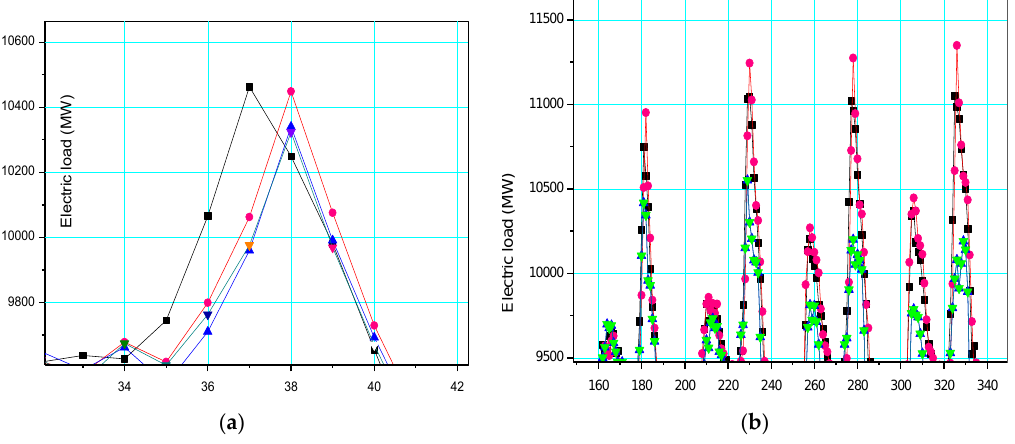
Figure 8. The local enlargement (peak) comparison of the DEMDQPSOSVRAR Model, the SVR model and the PSO-SVR model for ( a ) the small sample size ( 1 ) ; ( b ) the large sample size ( 2 ).